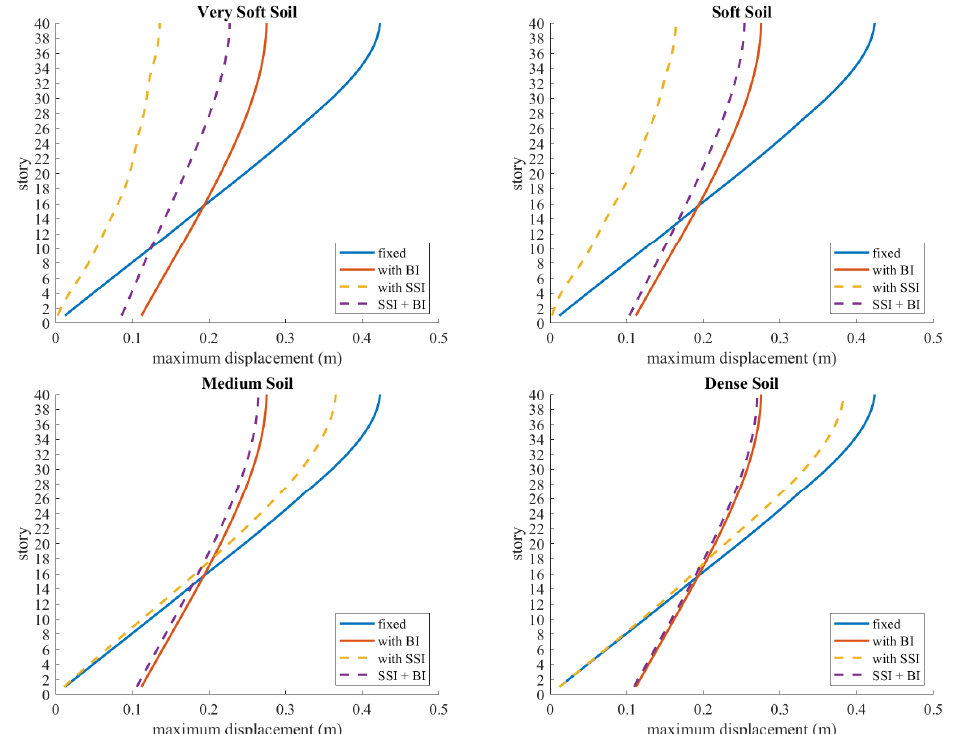
Figure 11. Maximum displacement of each story for the forty-story building (Imperial Valley, 1979).